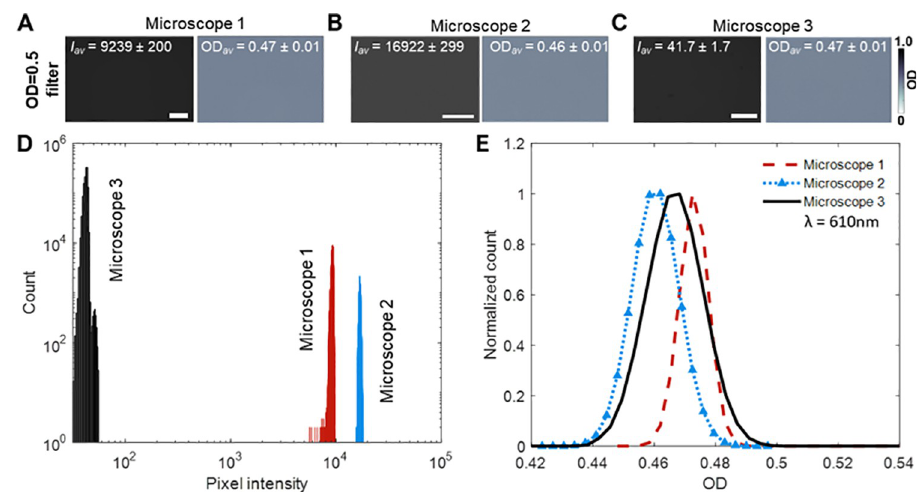
Fig 3. Demonstrating comparability of the absorbance imaging. (A-C) Using three different microscopes, a brightfield image of an OD = 0.5 neutral density (ND) filter was captured as shown on the left of each panel. Corresponding absorbance images are shown on the right. The average pixel values of intensity and OD are indicated on each image. Microscope 1: Biotek Lionheart FX, Microscope 2: Nikon Ti2; Microscope 3: Zeiss Axiovert S100; Microscopes 1 and 2 yield 16-bit while Microscope 3 yields 8-bit images. (D) Histograms of pixel intensities of the brightfield images do not overlap when imaging the same ND filter, which shows that pixel intensities cannot be used to compare data when using different microscopes. (E) Overlapping histograms of the OD values show that the absorbance microscopy method can be used to compare data collected on different microscopes (the number of pixels in each image presented on the y -axis count was normalized since the image dimensions for each microscope differ). All microscopes were equipped with a 610 nm bandpass filter. Scale bars: 200 μ